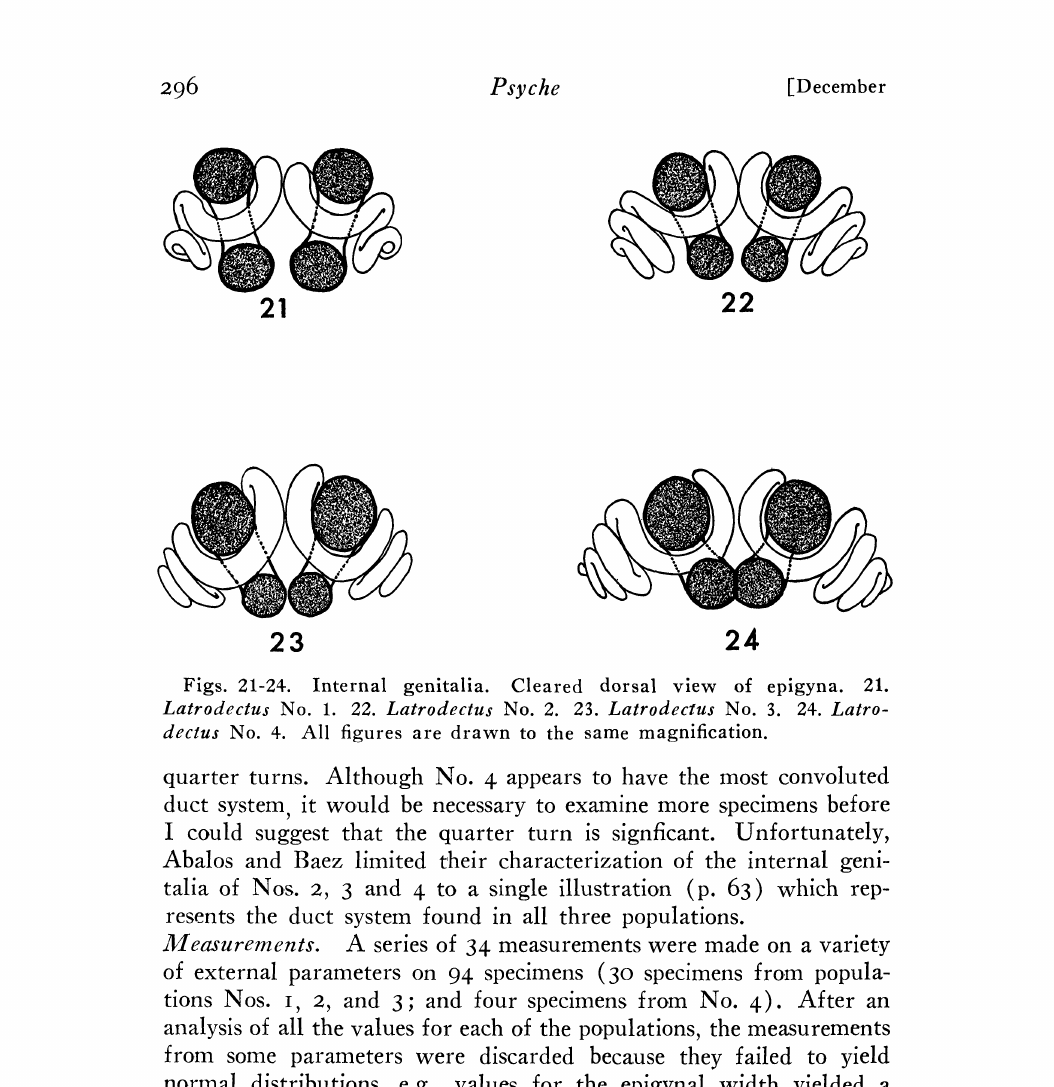
Figs. 21-24. Internal genitalia. Cleared dorsal view of epigyna. 21. Latrodectus No. 1. 22. Latrodectus No. 2. 23. Latrodectus No. 3. 24. Latro- declus No. 4. All figures are drawn to the same